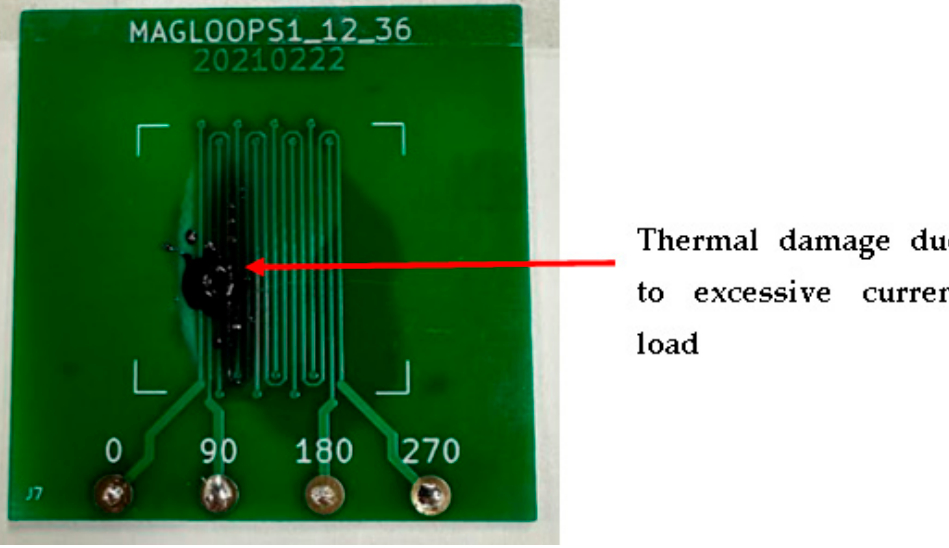
Figure 10. Photograph of the damaged chip during the forced convection setup.